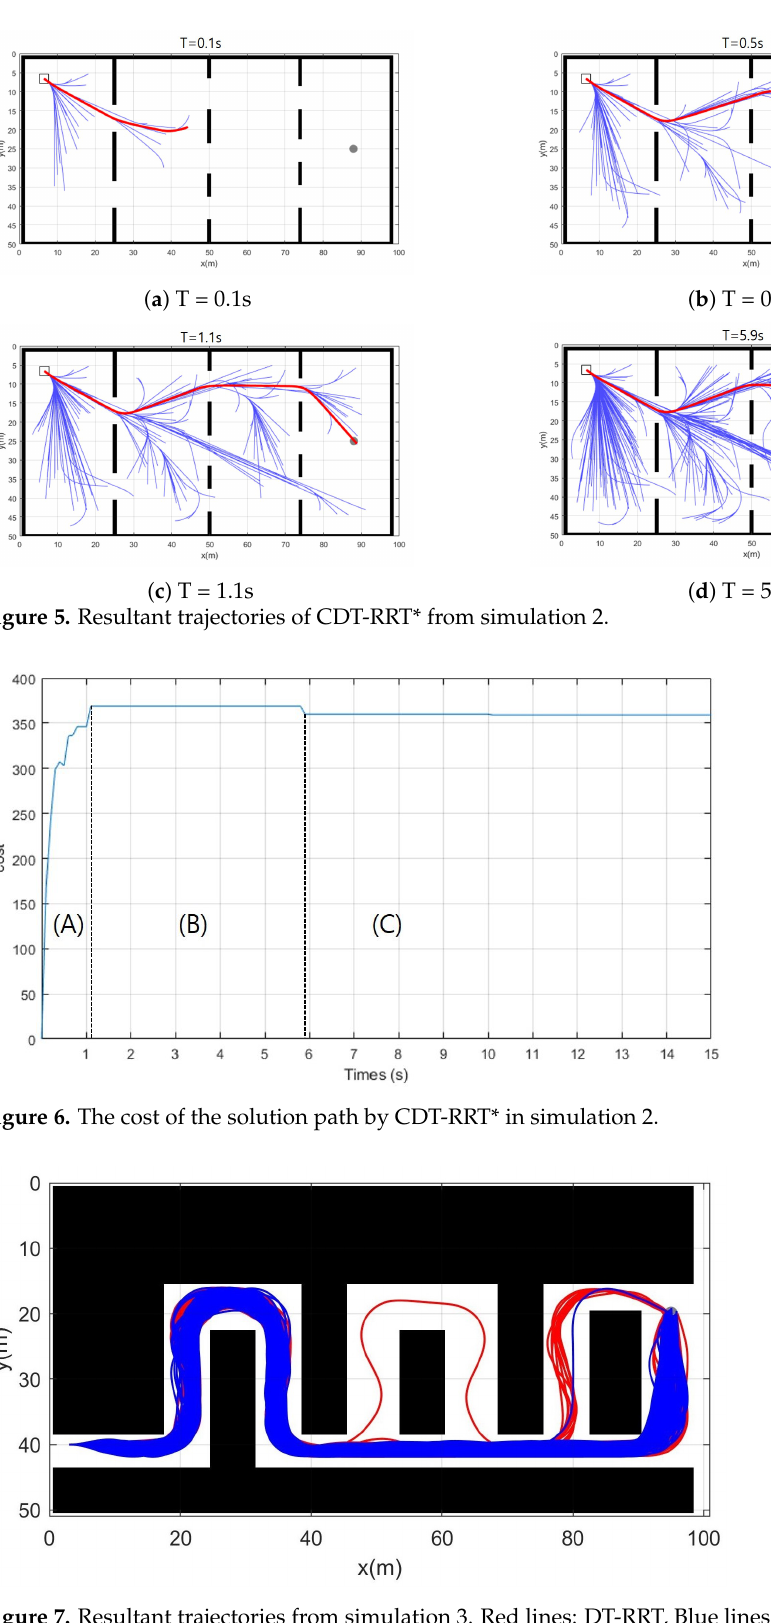
Figure 7. Resultant trajectories from simulation 3. Red lines: DT-RRT, Blue lines: